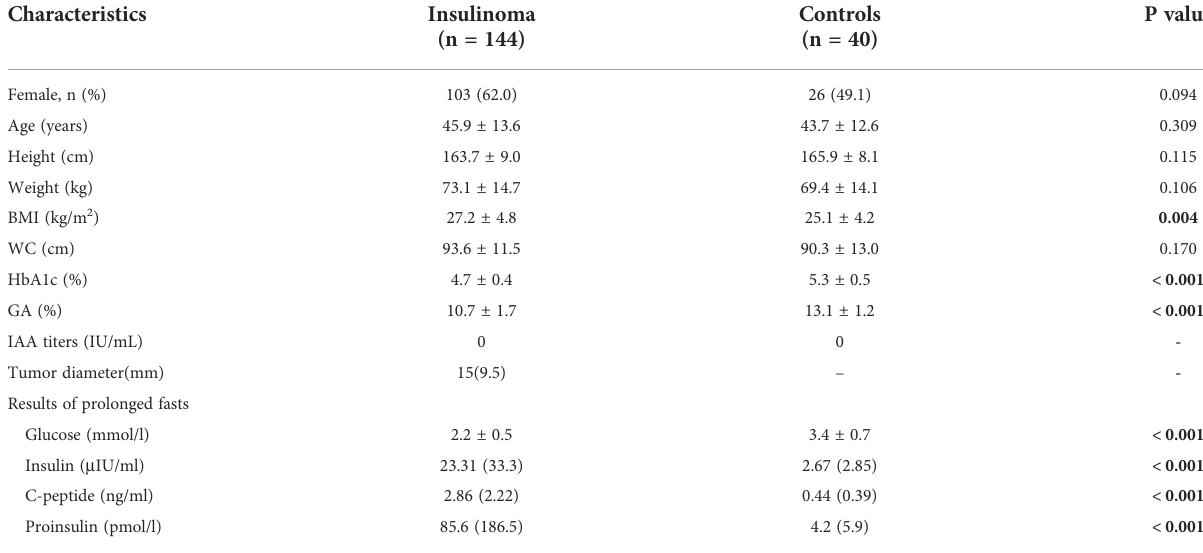
TABLE 1 Basic characteristics of patients with insulinoma and controls.